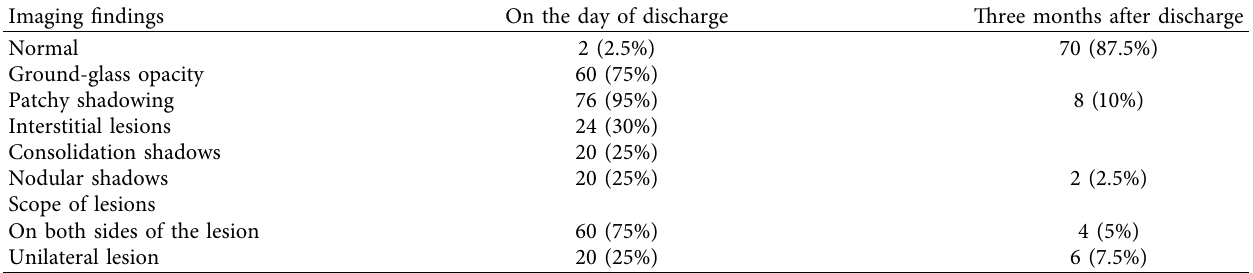
Table 4: Radiographic findings of COVID-19 patients ( n � 80).